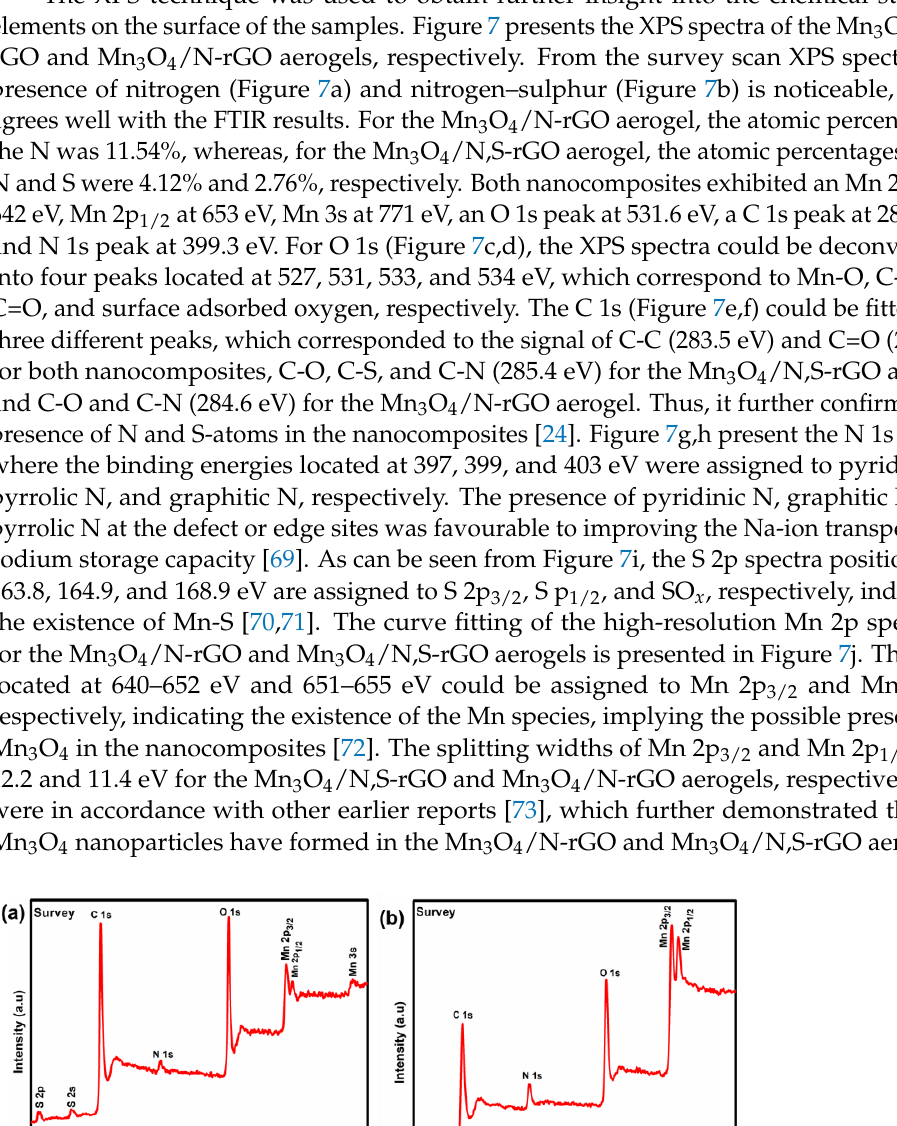
Figure 7. XPS spectra for the survey spectrum of ( a ) Mn 3 O 4 /N,S-rGO aerogel and ( b ) Mn 3 O 4 /N-rGO aerogel, O 1s spectra of ( c ) Mn 3 O 4 /N,S-rGO aerogel and ( d ) Mn 3 O 4 /N-rGO aerogel, C 1s spectra of ( e ) Mn 3 O 4 /N,S-rGO aerogel and ( f ) Mn 3 O 4 /N-rGO aerogel, N 1s spectra of ( g ) Mn 3 O 4 /N,S-rGO aero- gel and ( h ) Mn 3 O 4 /N-rGO aerogel, ( i ) S 2p spectra of Mn 3 O 4 /N-rGO aerogel and Mn 3 O 4 /N,S-rGO aerogel and ( j ) deconvoluted spectra of Mn 2p of Mn 3 O 4 /N-rGO aerogel.